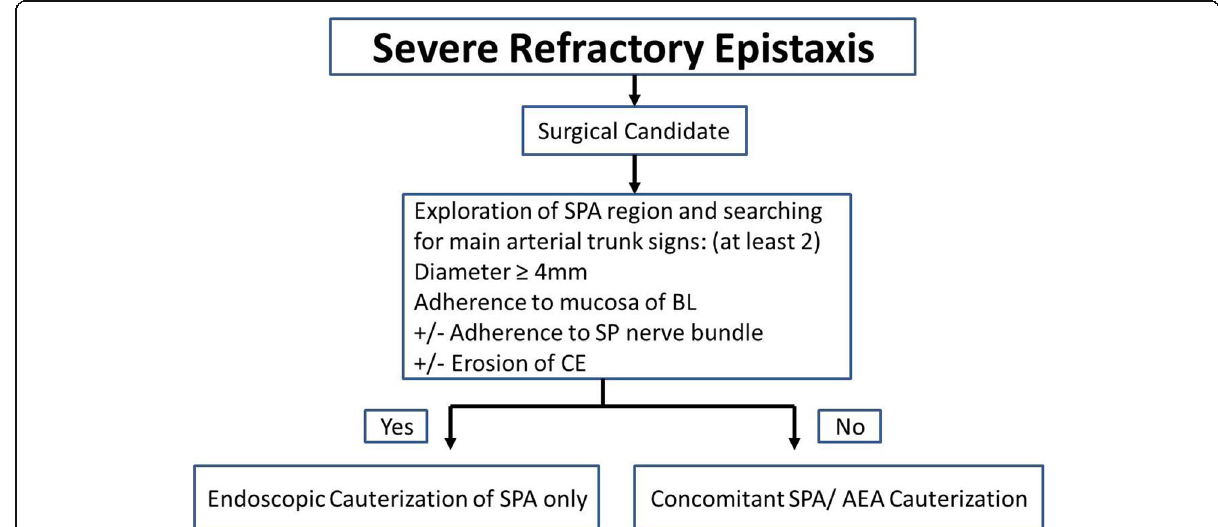
Fig. 5 Flow diagram for surgical management of severe epistaxis. SPA sphenopalatine artery, BL basal lamella, CE crista ethmoidalis, AEA anterior ethmoidal